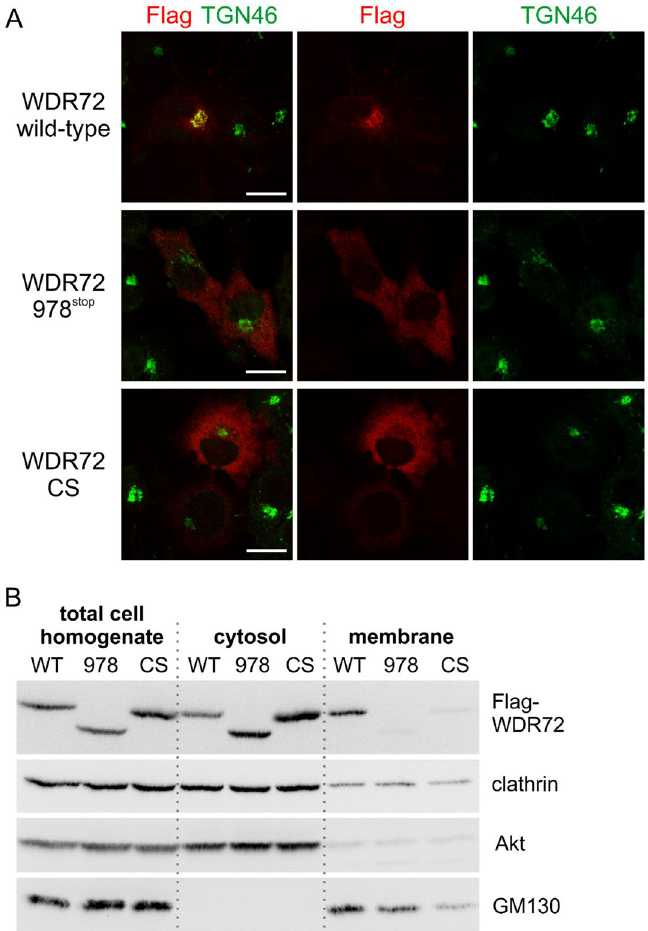
Figure 6. The C-terminal CAAX motif is required for WDR72 localization in the Golgi area. ( A ) The immunolocalization of Flag-tagged WDR72 wild-type, AI WDR72 mutant form (978 stop ), and CAAX mutant form (CS) was investigated using anti-Flag antibody together with the endogenous Golgi marker TGN46. The immunolocalization of CS form was found to be in the cytoplasmic region similar to that of AI WDR72 mutant form. Scale bar represents 25 μm. ( B ) The CAAX mutant, WDR72 CS form, is predominantly detected in the soluble cytosolic fraction. Cell fractionation assay was performed and the expression levels of WDR72 wild-type (WT), AI mutant form (978) and CAAX mutant form (CS) were evaluated. WDR72 WT was detected in both the cytosolic and membranous fractions with slight enrichment in the membranous fraction, while 978 and CS were very predominantly soluble. Anti-clathrin, anti-Akt and anti-GM130 antibodies were used to verify the successful separation of cytosolic and membranous